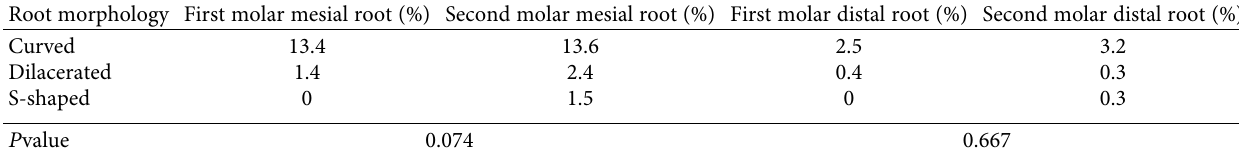
Table 2: The frequency distribution and percentage of the root shapes in the first and second permanent mandibular molars.